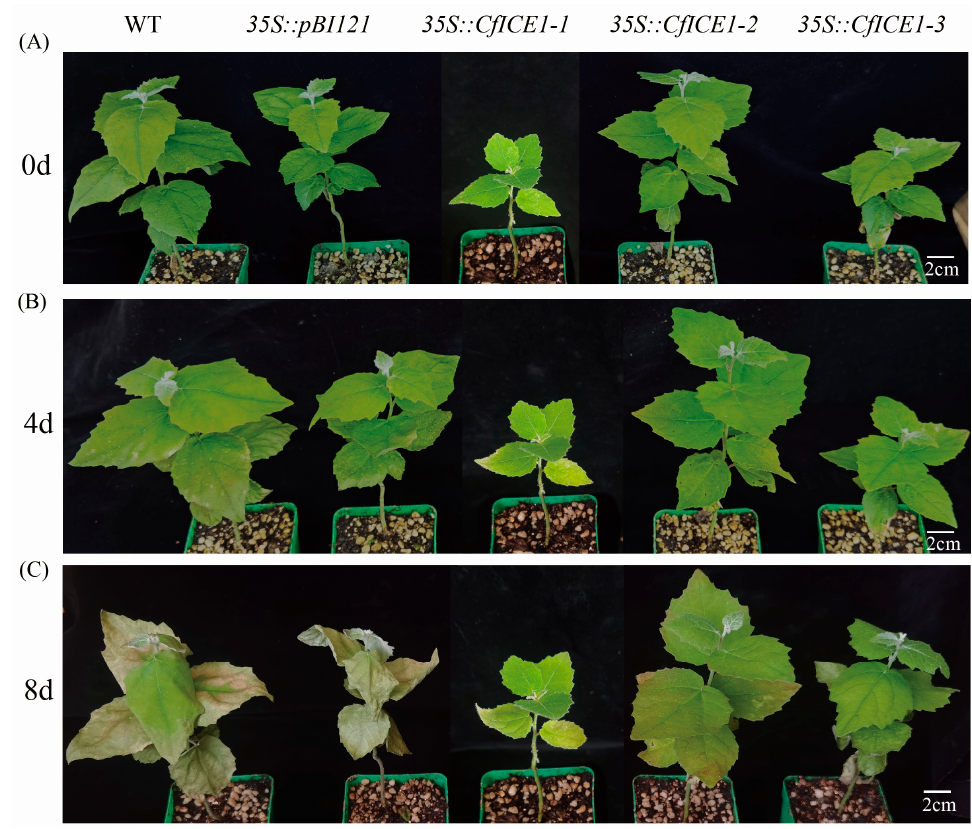
Figure 4. Phenotypic changes of transgenic, empty vector and wild ‐ type poplar lines under ( A ) 0, ( B ) 4 and ( C ) 8 days of salt stress.